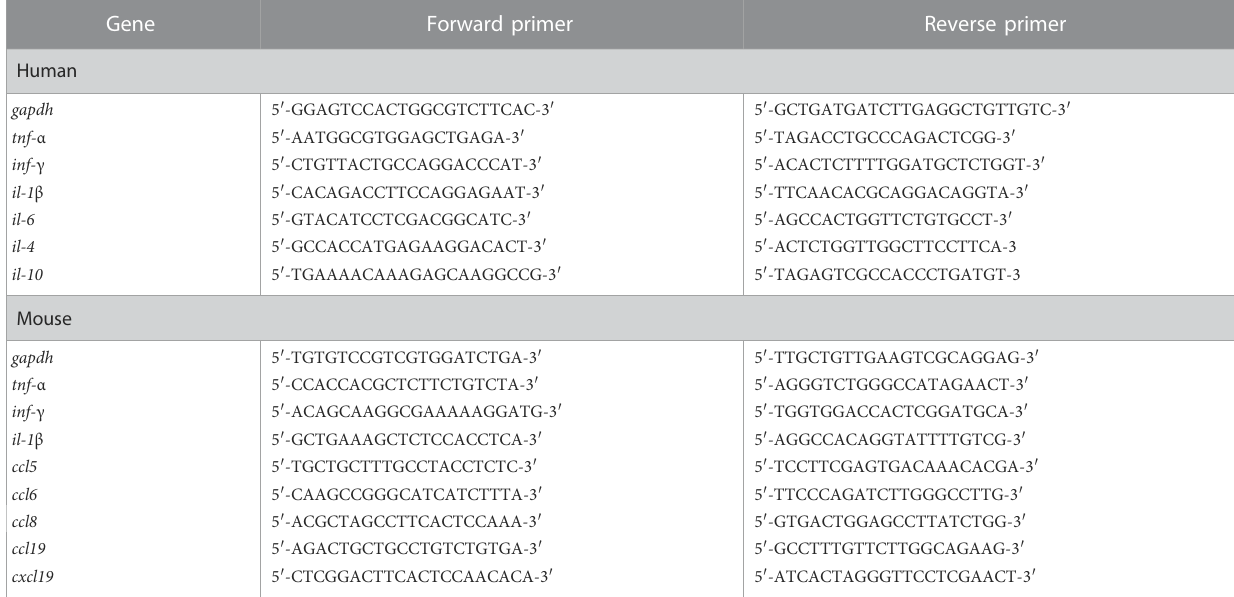
TABLE 4 Primer sequences used for quantitative PCR analysis.